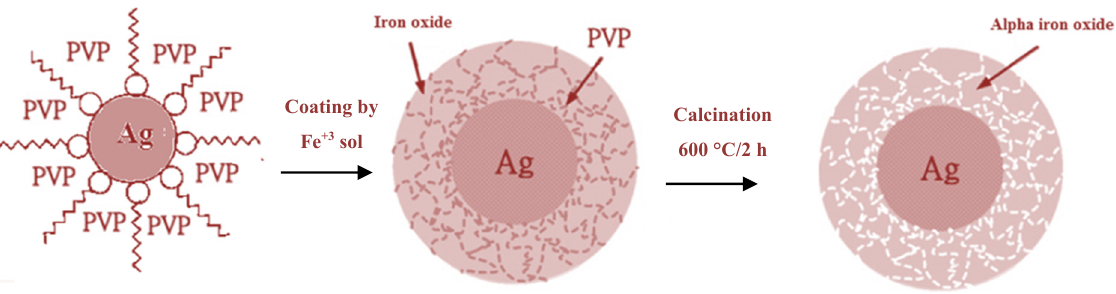
Figure 5. Schematic mechanism for the formation of core@shell structured Ag@ α -Fe 2 O 3